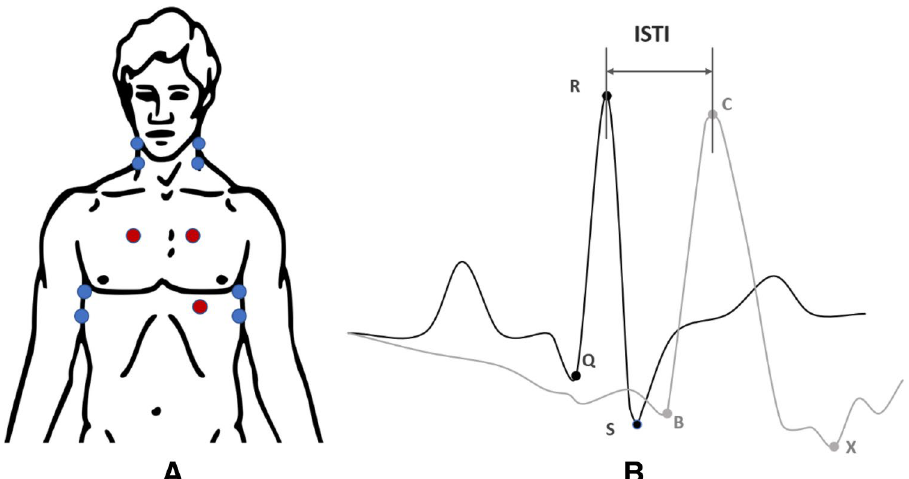
Figure 2. ( A ) The positions of ECG (in red) and ICG (in blue) electrodes. ( B ) The ECG (dark grey) and ICG signals (light gray). The Initial Systolic Time Interval (ISTI) is calculated on the time interval between the R-wave peak (ECG) and the peak of the dZ/dt wave (ICG)-C